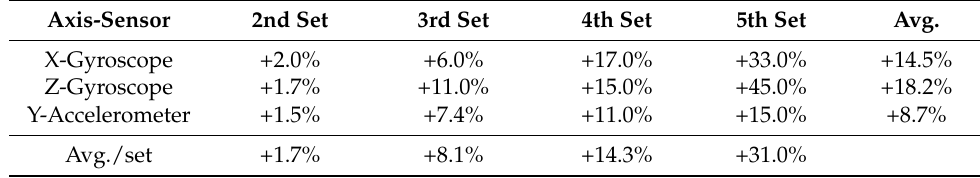
Table 3. The increase in the time to complete a set compared to the 1st